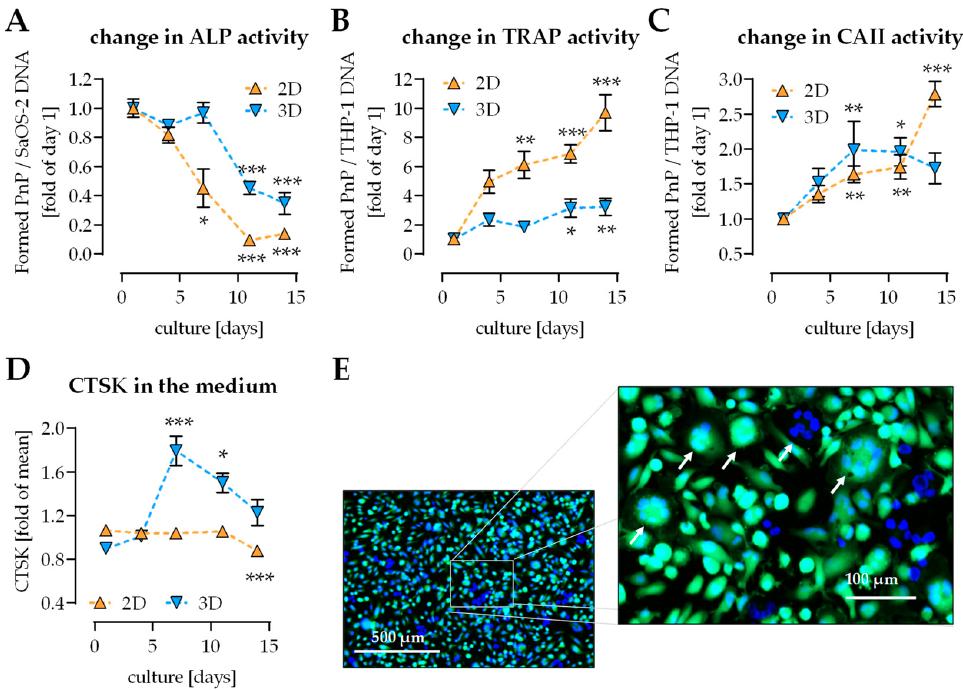
Figure 2. Comparison of functionality of THP-1 cells and SaOS-2 cells in 2D and 3D coculture. THP-1 cells and SaOS-2 cells (2:1 ratio) were cocultured over 14 days in 2D and 3D on pHEMA-based cryogel scaffolds. On days 1, 4, 7, 10, and 14 of culture, ( A ) alkaline phosphatase (ALP) activity, ( B ) tartrate-resistant acidic phosphatase (TRAP) activity, ( C ) carbonic anhydrase II (CAII) activity, and ( D ) cathepsin K (CTSK) levels were measured. ( E ) On day 7 life-dead-staining revealed the presence of large multinucleated cells (arrow). Data are presented as curves (mean ± SEM). Changes over time were compared by nonparametric Friedmann test, followed by Dunn’s multiple comparison test. * p < 0.05, ** p < 0.01, and *** p < 0.0001 as compared to the respective day 1. N ≥ 3 and n = 3.